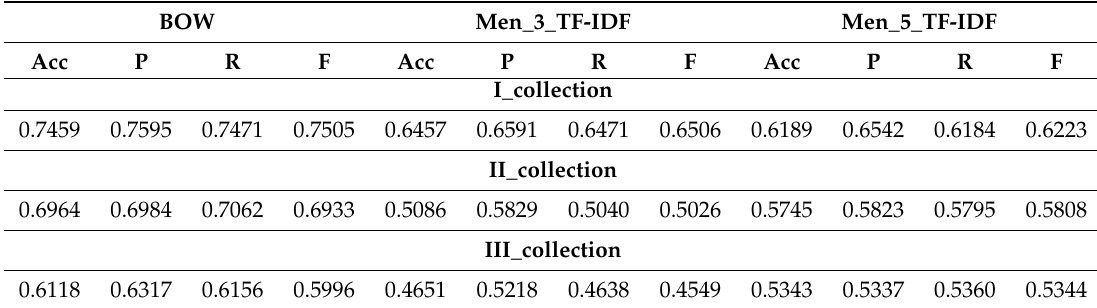
Table 2. Quality measurements for the classification of microblog posts by sentiment for collections staggered over